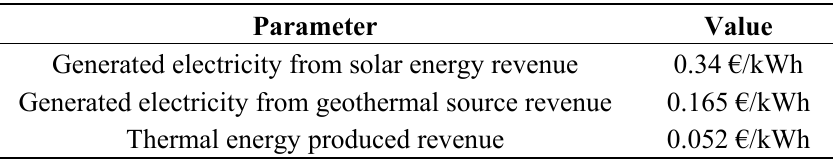
Table 1. Specific revenues of the